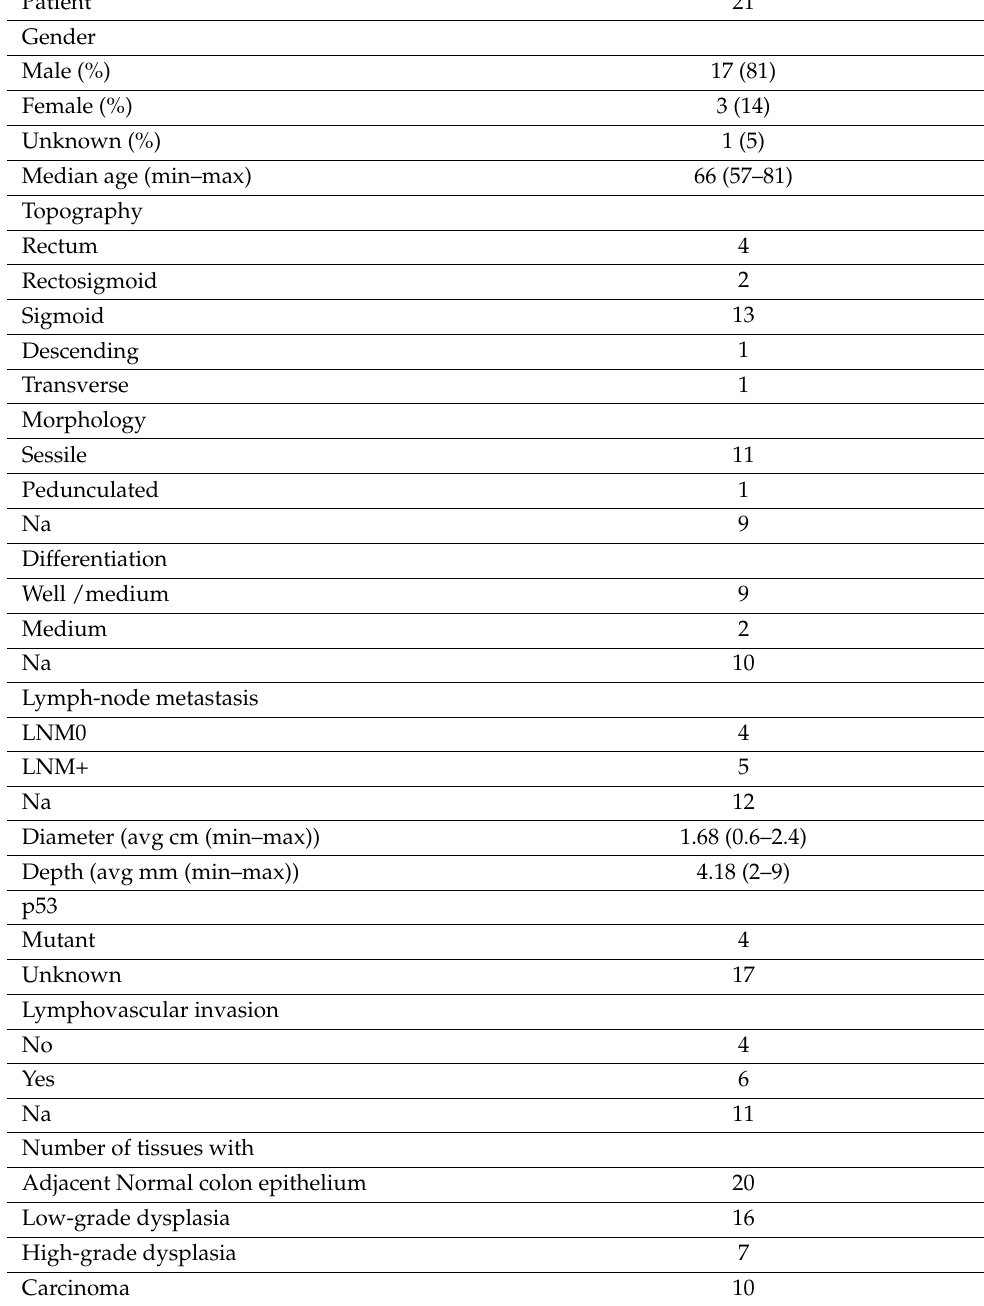
Table 1. Summary of the analyzed